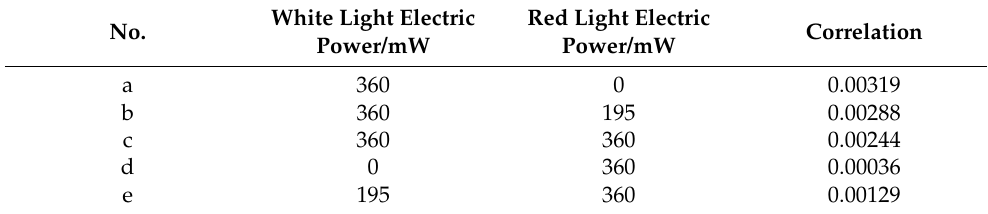
Table 1. Analysis of the difference between non-moldy and moldy areas under multiple light sources.